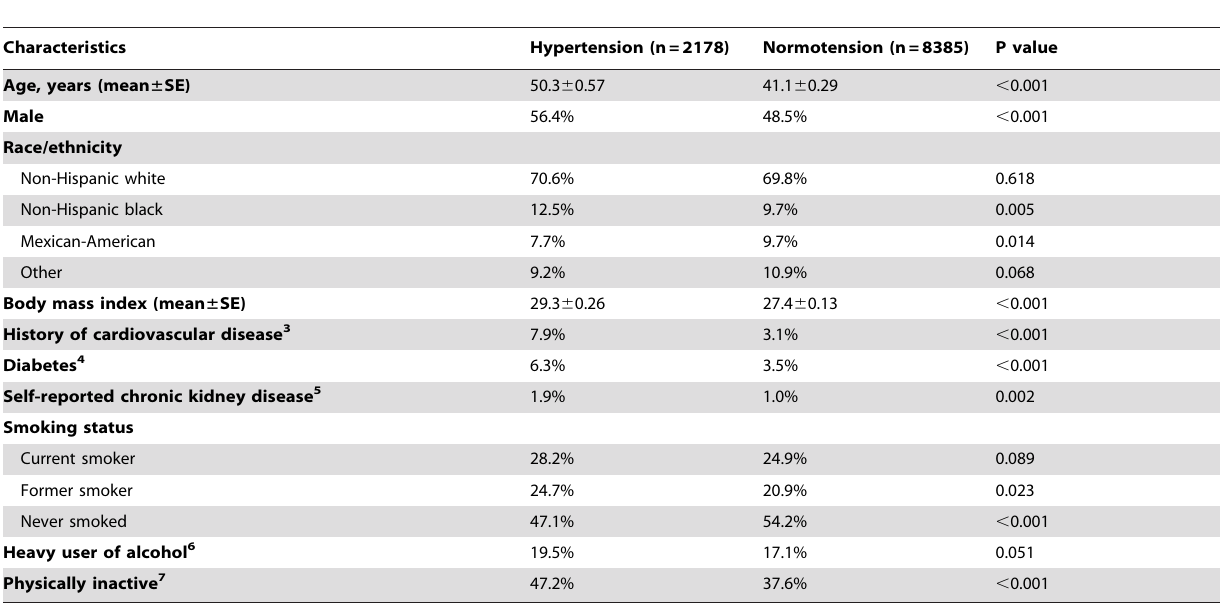
Table 1. Comparison of selected characteristics between hypertensive and non-hypertensive participants among U.S. adults